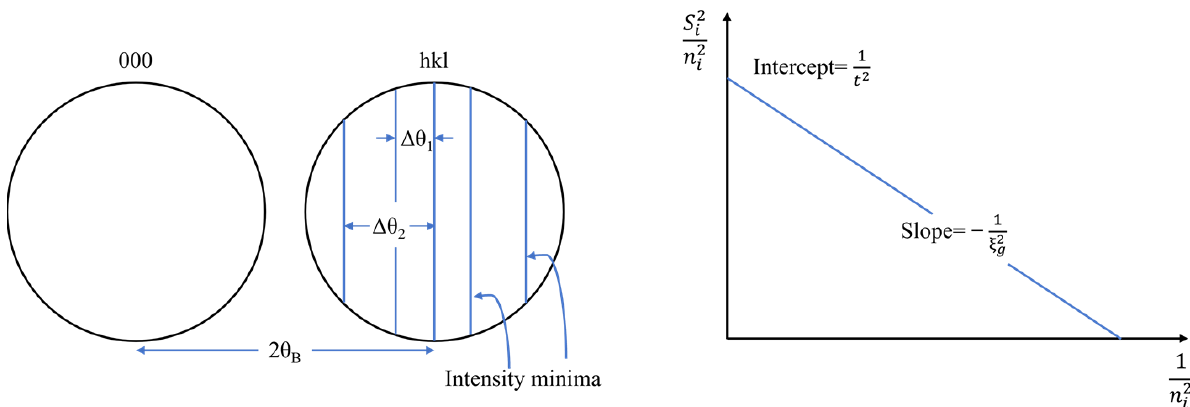
Figure 1. Schematic diagram of fi lm thickness measurement by CBED method [34].